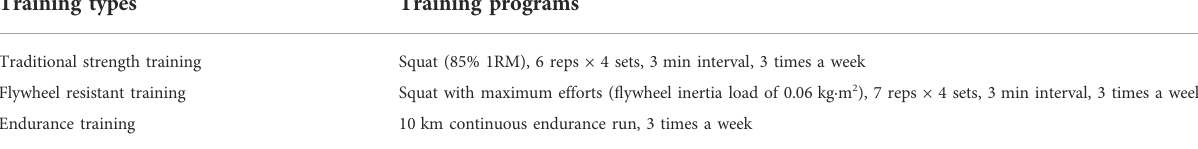
TABLE 2 Schedule of different training